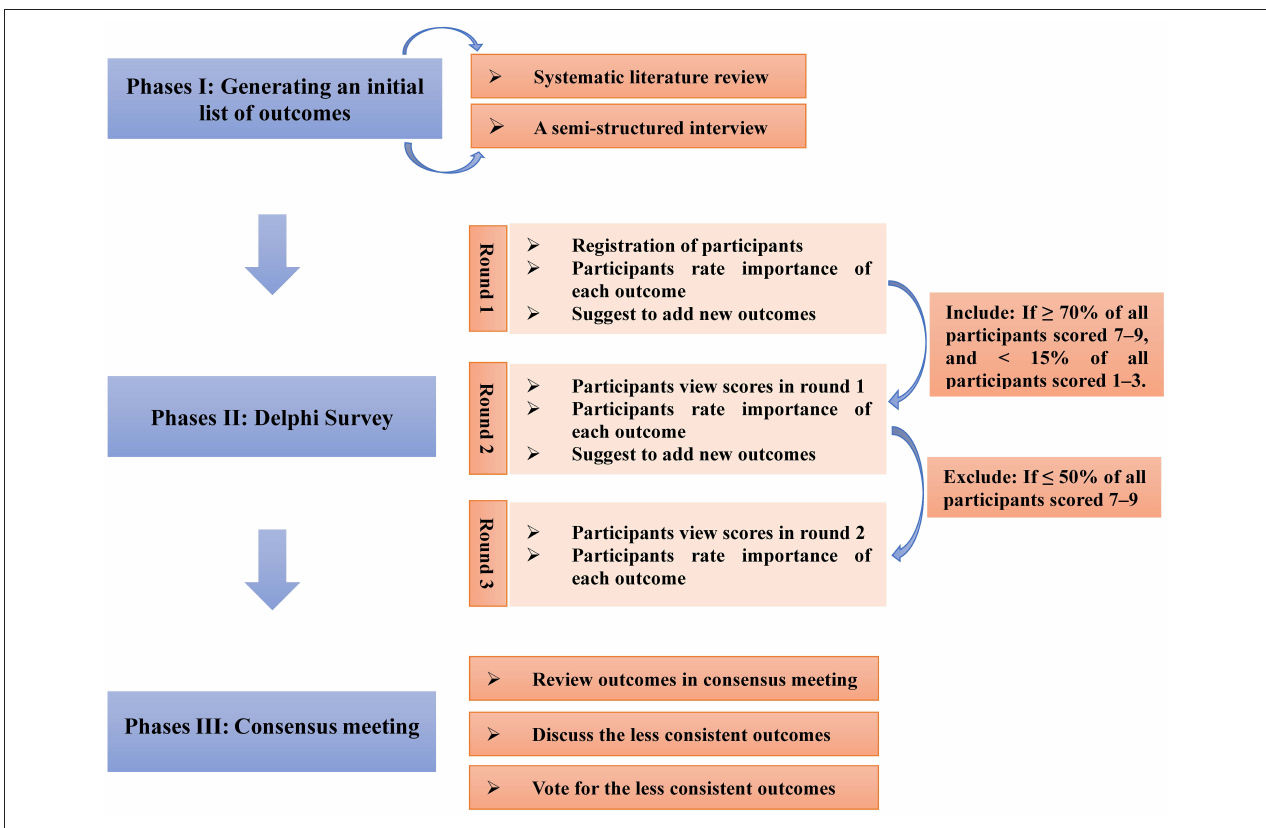
FIGURE 1 | Key phases in